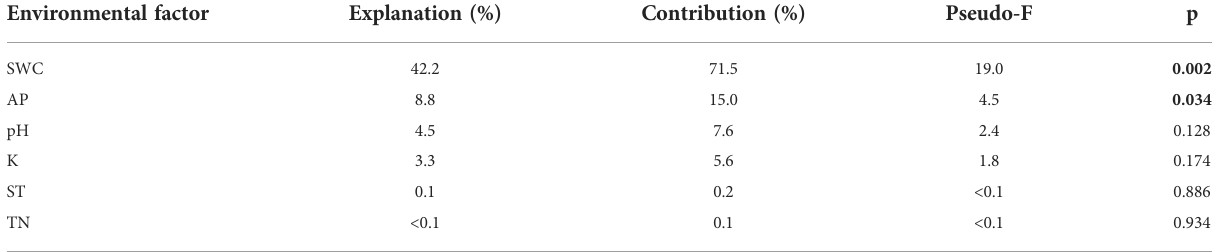
Bold parts indicated signi fi cant differences at the p<0.05